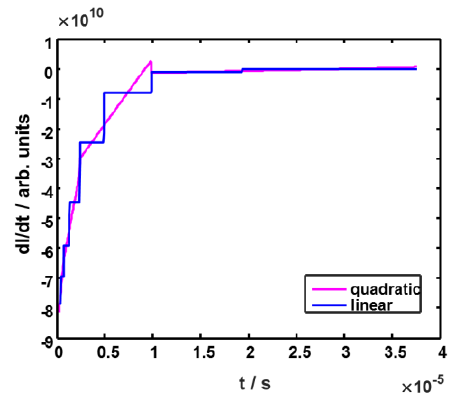
Fig. 3: Derivatives of the straightforward local approximations